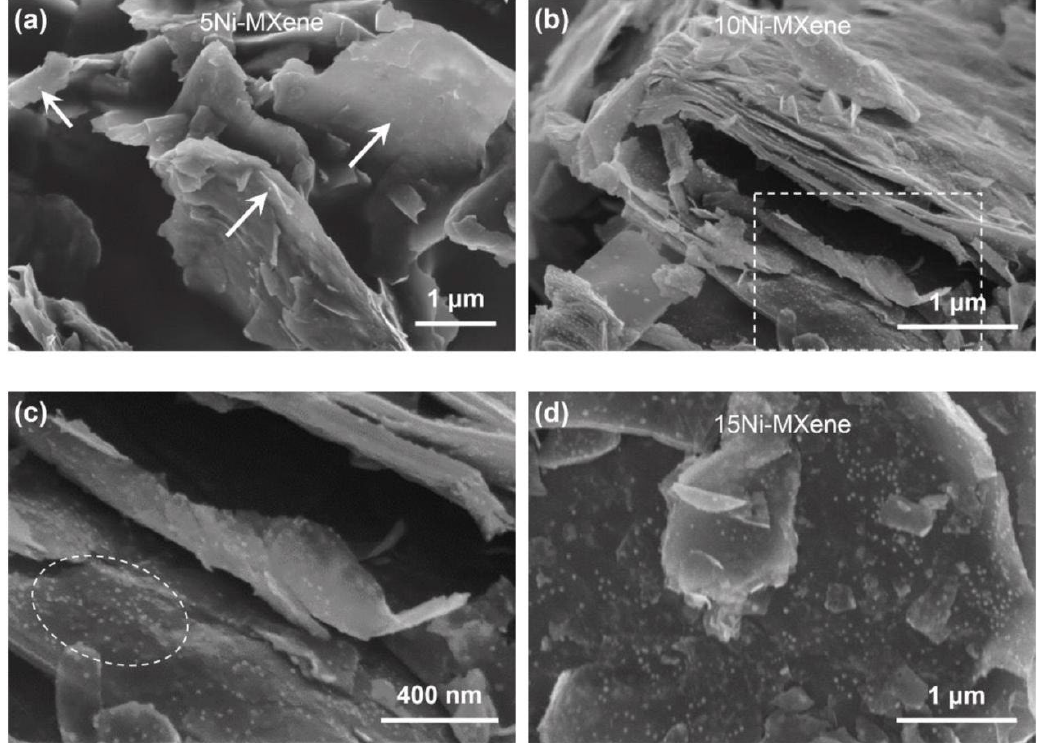
Figure 27. The secondary electron SEM images of Ni-MXene after annealing: ( a ) 5Ni-MXene, ( b ) 10Ni-MXene, ( c ) the enlarged image corresponding to the rectangular area marked in ( b ), and ( d ) 15Ni-MXene [75].